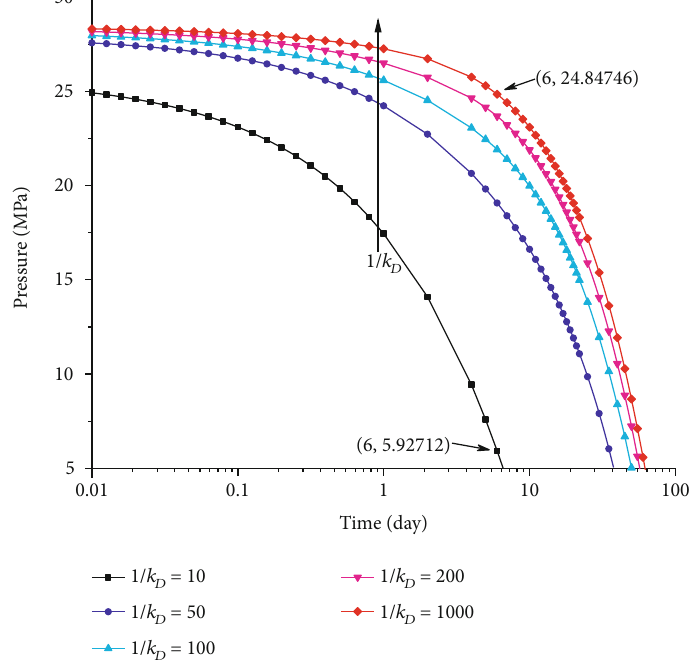
Figure 7: E ff ect of mobility ratio on the wellbore pressure (constant